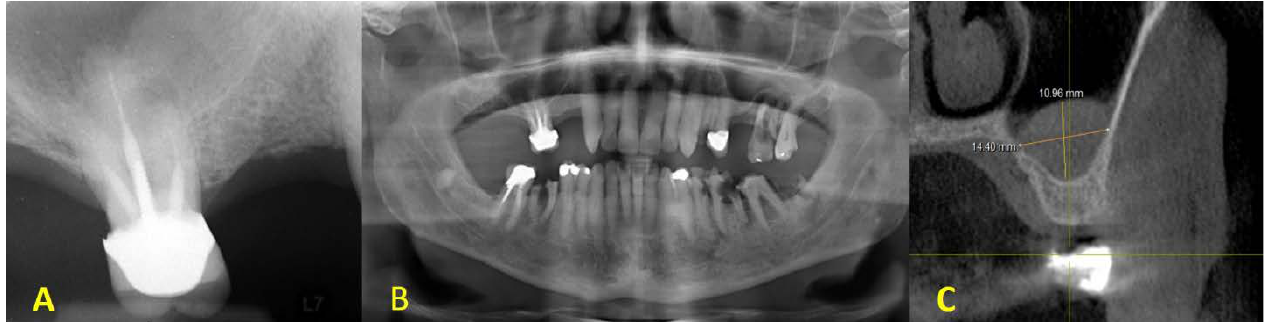
Figure 2. Preoperative radiographic evaluation: ( A ) homogenous solitary radiopaque mass observed on the right sinus floor in intraoral periapical with a periapical lesion on the MB root of the right maxillary molar; ( B ) a panoramic radiograph prior to initial therapy; ( C ) CBCT cross-sectional view of mucocele/antral pseudocyst with a patent osteomeatal